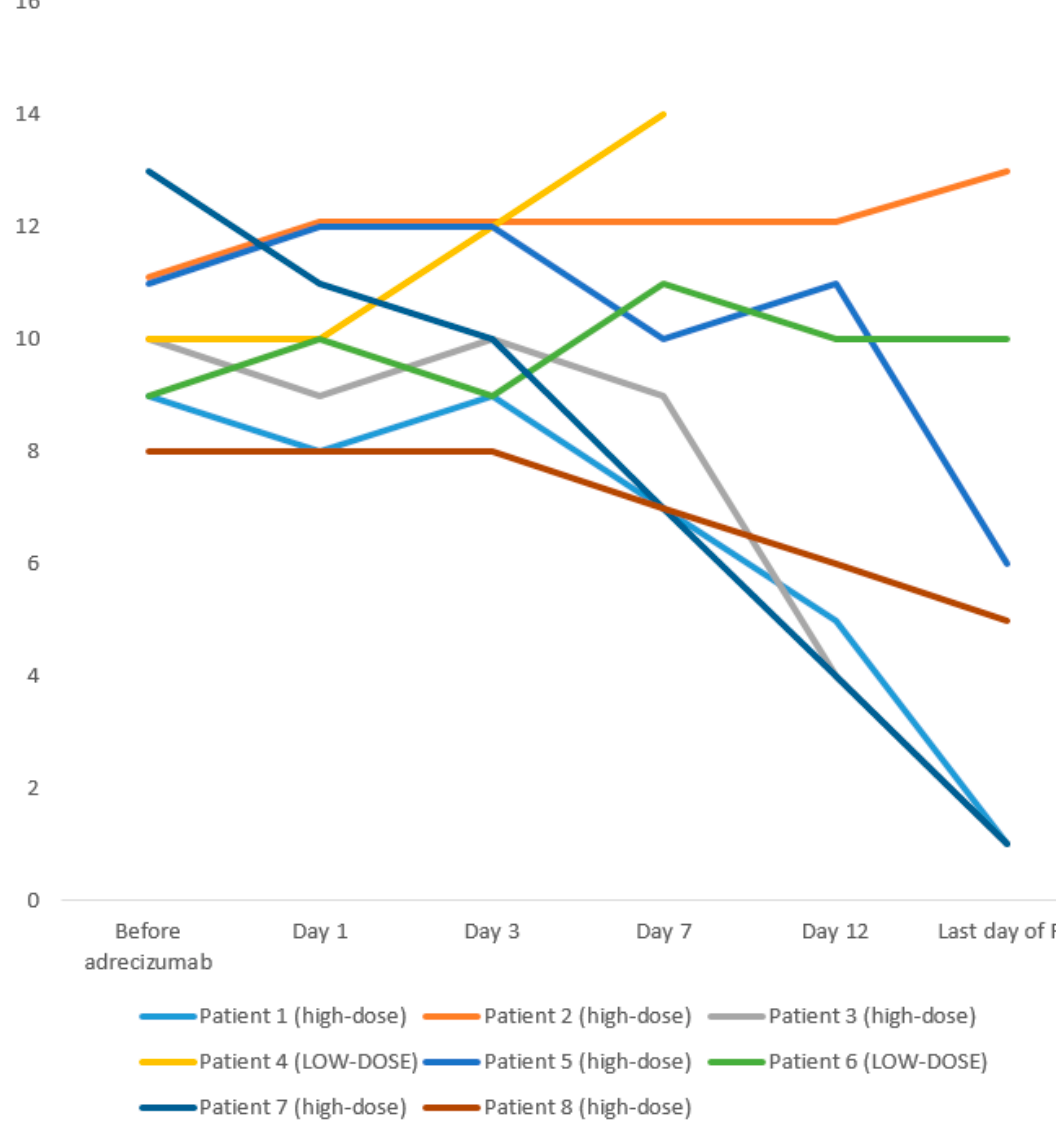
Figure 1. Change in the clinical severity score during follow-up. FU = follow-up; ICU = intensive care unit; VA = veno-arterial; VV = veno-venous. Scoring system: maximum 16, minimum 0-with higher scores indicating more severe illness. Vital and hospitalization status: deceased (5), on ICU ward (3), on normal ward (1), discharged (0). Circulation: VA-ECMO (4), max. noradrenaline > 0.40 µ g / kg / min (3), max. noradrenaline 0.40–0.10 µ g / kg / min (2), max. noradrenaline < 0.10 µ g / kg / min (1), no vasopressor (0). Ventilation status: VV-ECMO (4), mechanical ventilation BIPAP (3), intermittent mechanical ventilation CPAP (2), non-invasive ventilation (1), no ventilation at all (invasive / non-invasive) (0). Mean PaO2 / FiO2: ≤ 100 (3), 101–200 (2), 201–300 (1), > 300